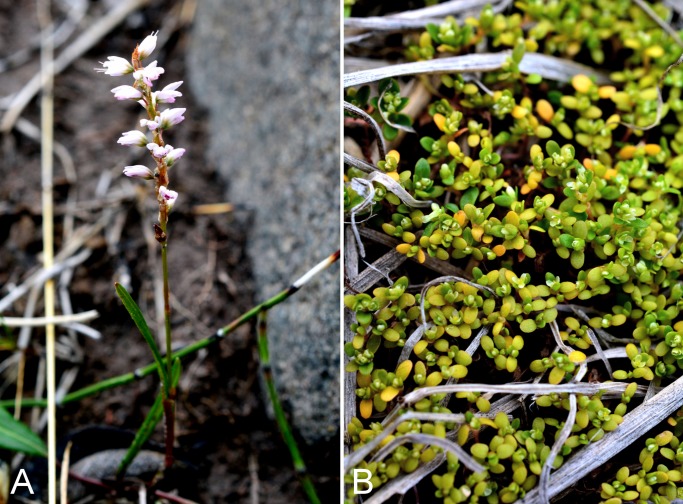
Bistorta vivipara and Koenigia islandica.Bistorta vivipara: (A) habit, Kugluk (Bloody Falls) Territorial Park, Nunavut, 17 July 2014. Koenigia islandica: (B) habit, Saarela et al. 4315. Photographs by P. C. Sokoloff.